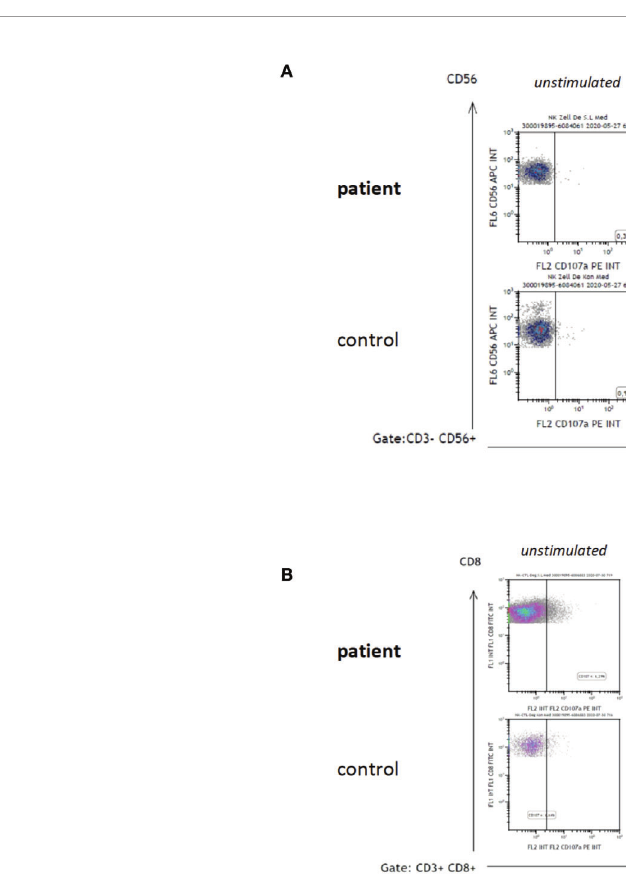
FIGURE 2 | CD107a degranulation assay. Degranulation of CD56+ NK-cells (A) and CD8+ CTL (B) was examined as previously published 7 . In brief, CD107a- expression on cell surfaces was analyzed by fl ow-cytometry in resting cells ( A , B; left dot plot diagrams ) and subsequent to 48 h stimulation with interleukin 2 (IL-2) of NK-cells ( A , right dot plot diagrams ), and phytohemagglutinin (PHA)/IL-2 of CD8+ T-cells ( B , right dot plot diagrams ),